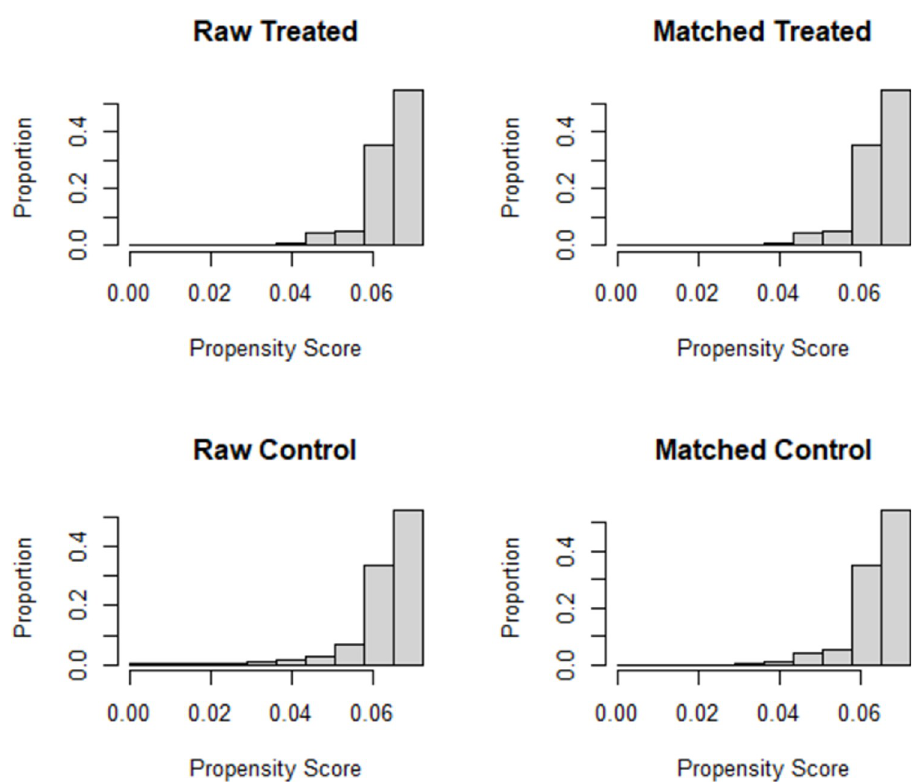
Fig 2. Graphs showing matching results by propensity score (PSM). Source: Calculated by the authors. Software R